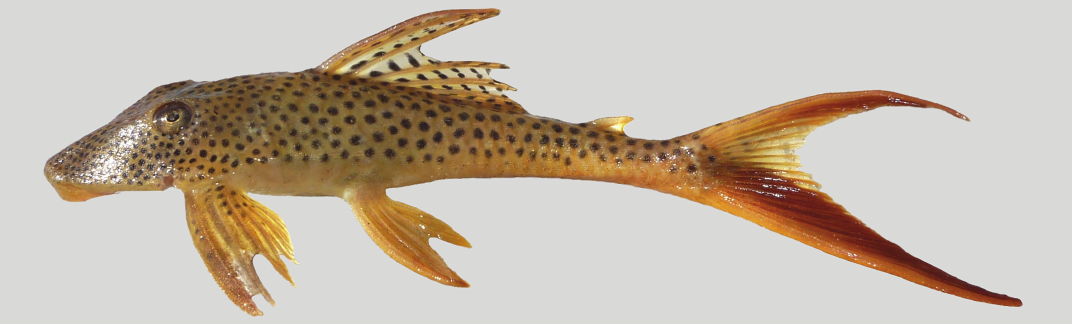
Fig. 2. Lateral view of Aphanotorulus rubrocauda , MNRJ 37551, paratype, 118.6 mm SL, Brazil, Mato Grosso State, Aripuanã Municipality, rio Aripuanã basin, 500 meters downstream of the rapids of Dardanelos waterfalls. Photographed alive by Fabio